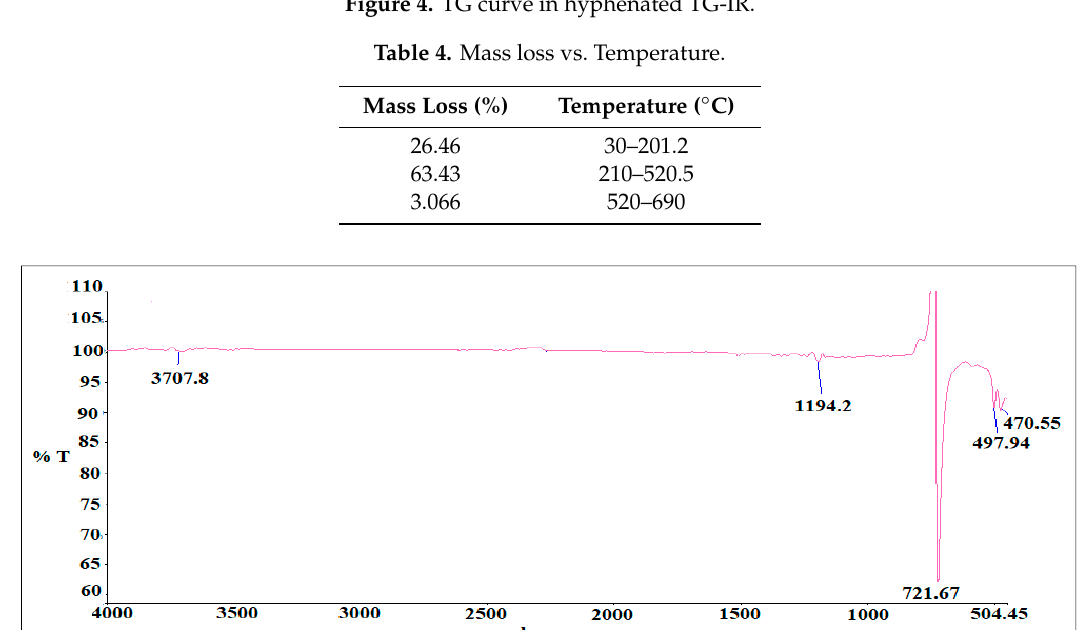
Figure 5. IR spectrum of as ‐ synthesized surfactant in hyphenated TG ‐ IR (curve 1).